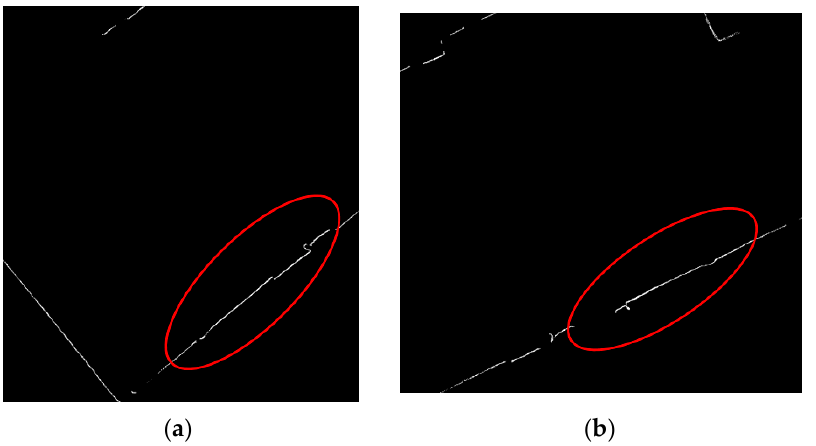
Figure 14. Case where the source and target ortho-projected images only have one corresponding line due to the limited scanning distance. ( a ) Target ortho-projected image generated from S17 in CB; ( b ) source ortho-projected image generated from S18 in CB. The lines inside the red circle are corresponding walls.